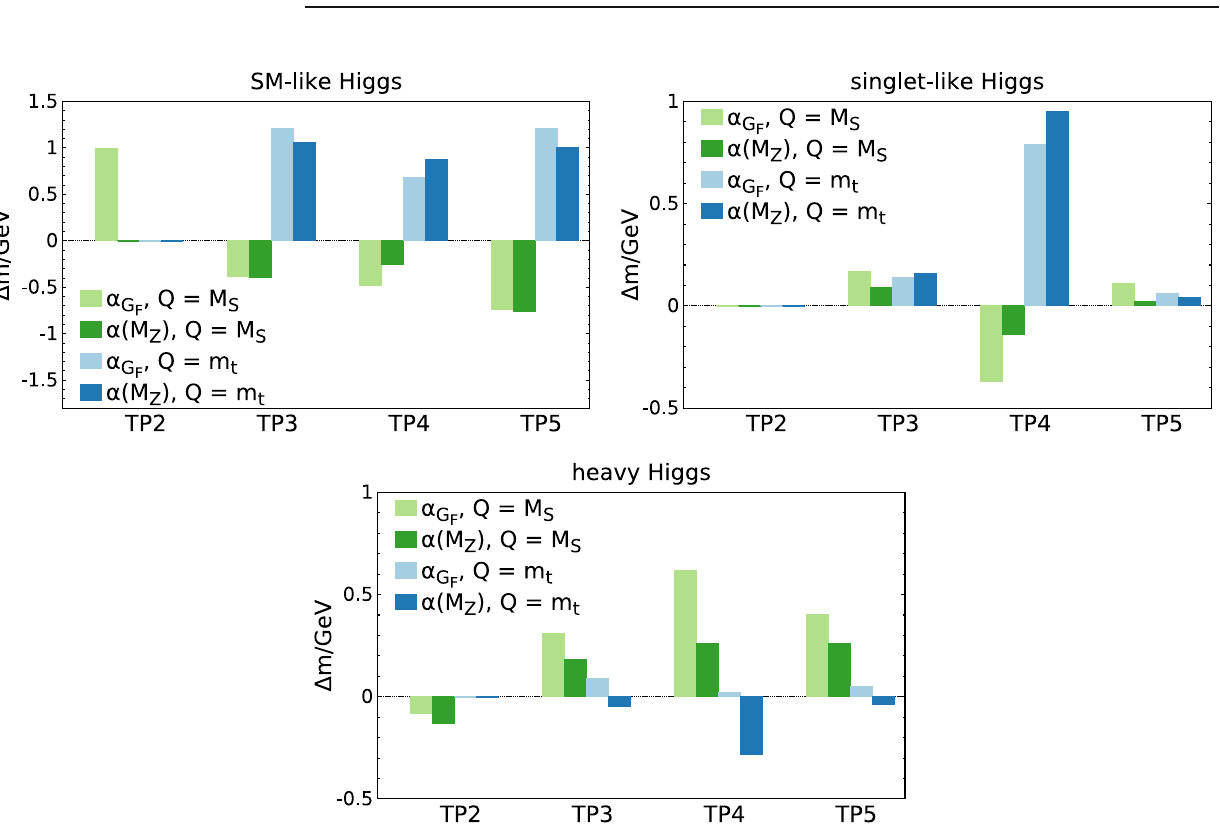
− M N-FH at the scales M S ( green ) and m t ( blue ) between NMSSMCALC and NMSSM-FeynHiggs with h h ( bright ) and α( M Z ) ( dark F